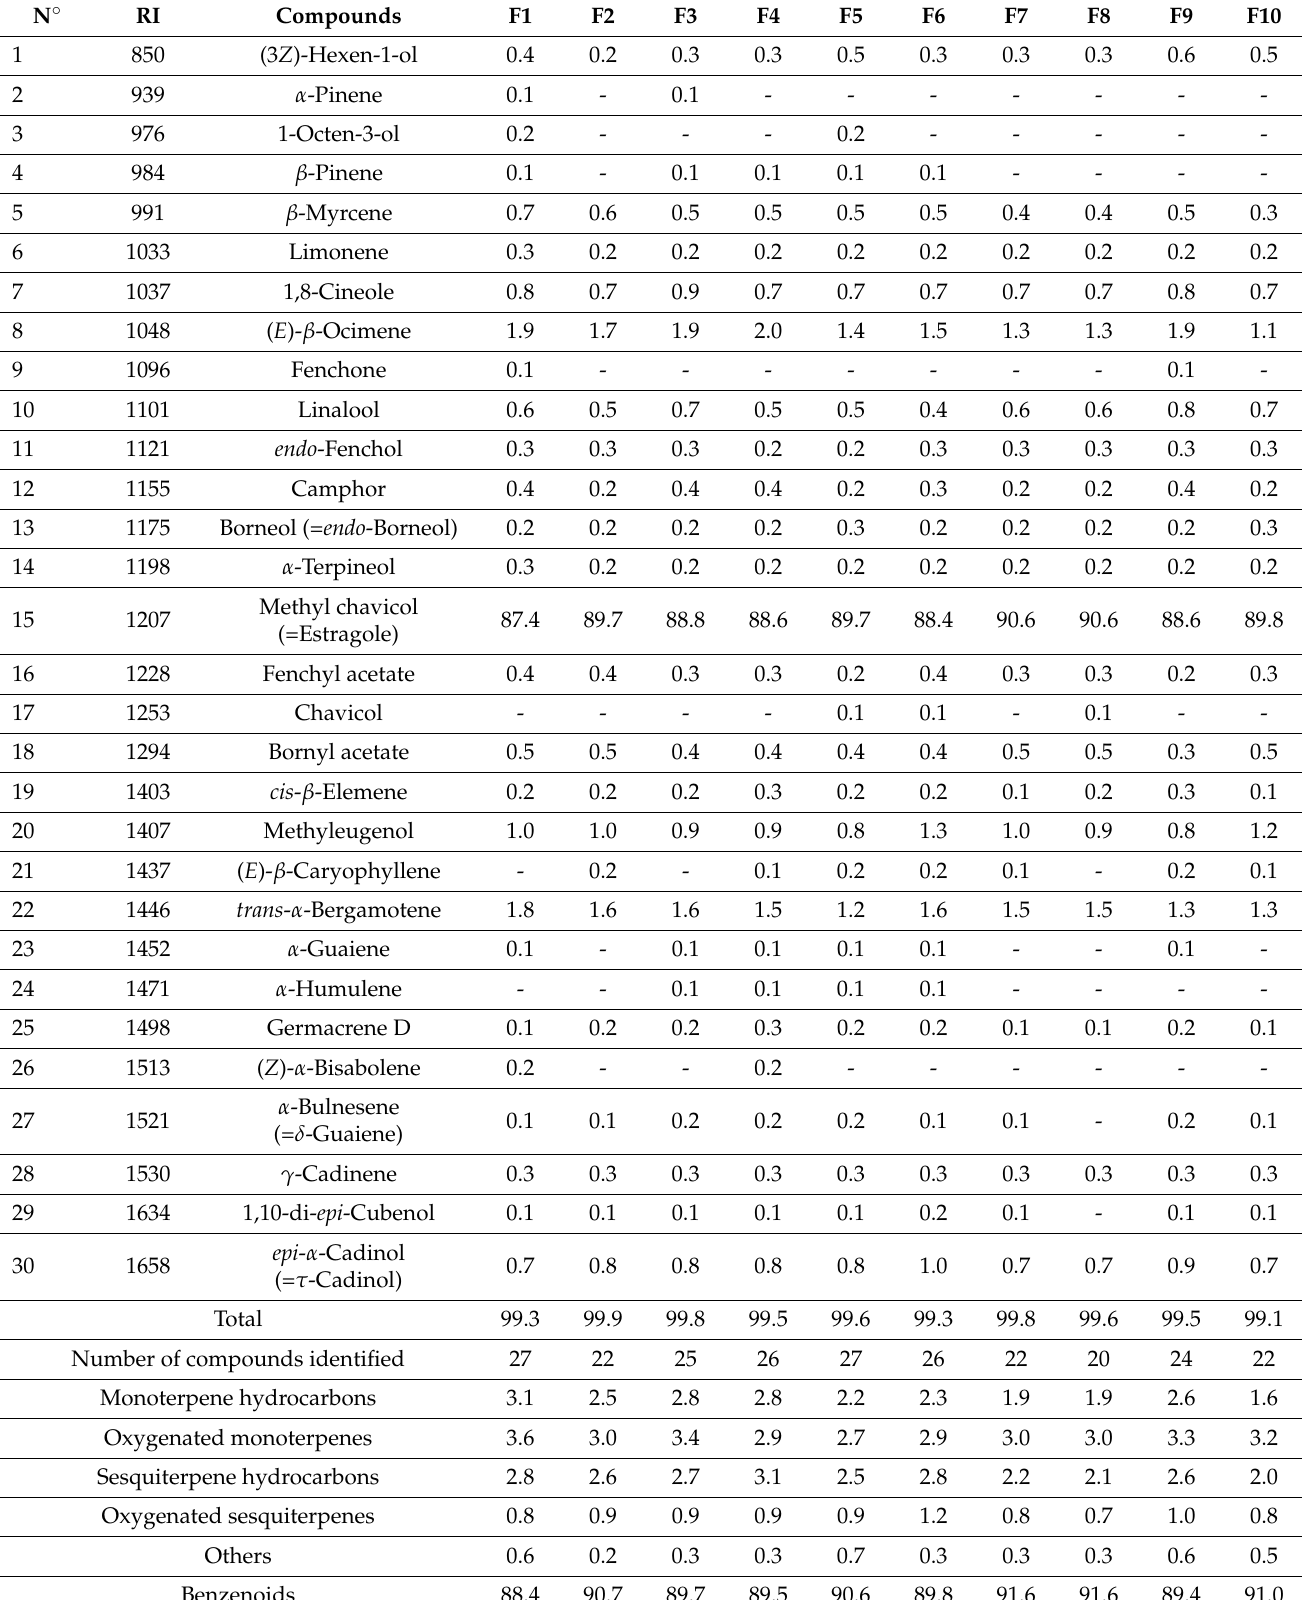
Table 3. Composition of essential oils of O. basilicum cultivated under different light